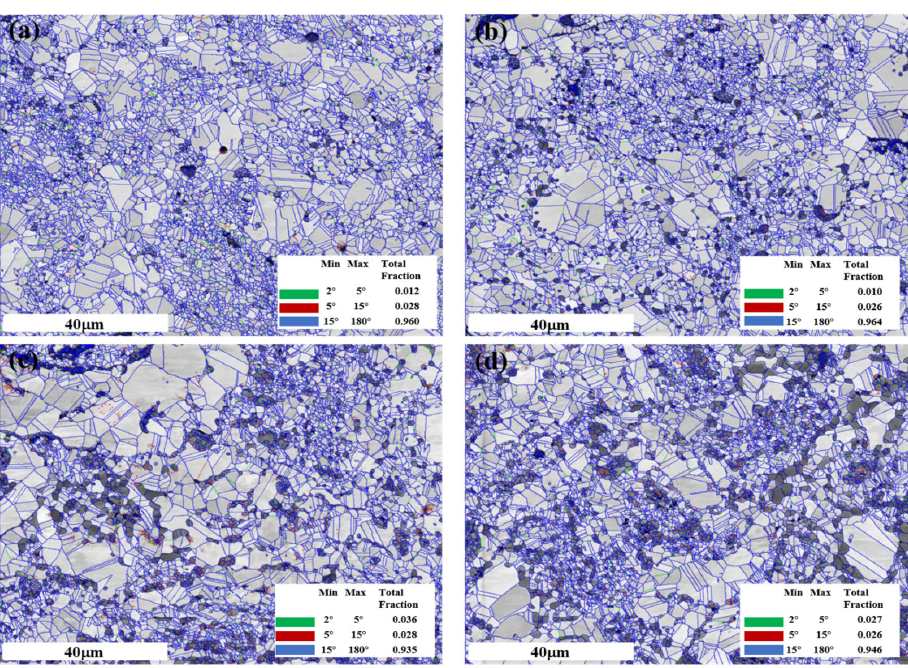
Figure 5. XRD patterns of Ni ‐ 20Cr ‐ Eu 2 O 3 composites.